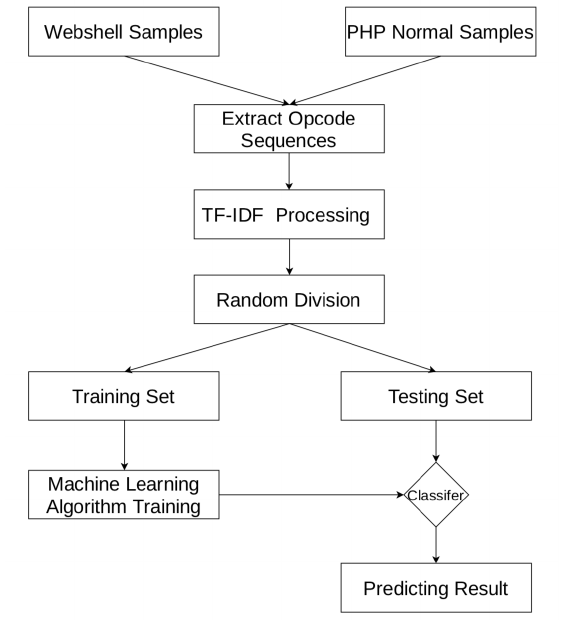
Figure 3. Process flow.